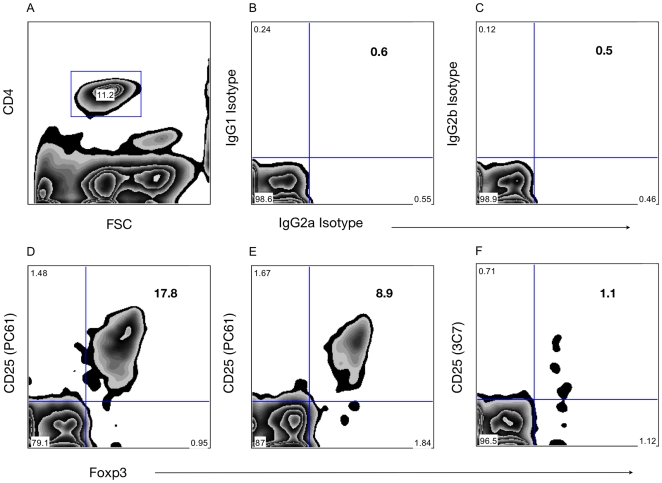
Representative analysis of CD4+CD25+Foxp3+ cells in blood of C57BL/6 mice.Percentages of CD25+Foxp3+ Treg gated in CD4+ T cell in the peripheral blood. Representative example of the gating in CD4+ T cells and the isotype controls used for CD25 (IgG1: pC61, IgG2b: 3C7) and Foxp3 (IgG2a) are shown in the upper panel (A, B, C). Representative analysis of CD25+Foxp3+ Treg in Group 1, i.e. islet transplantation without further therapy, at day 20 post-transplantation (D) in naive mice (E) and in Group 7, i.e early anti-CD25 mAb at day 20 post-transplantation (F).